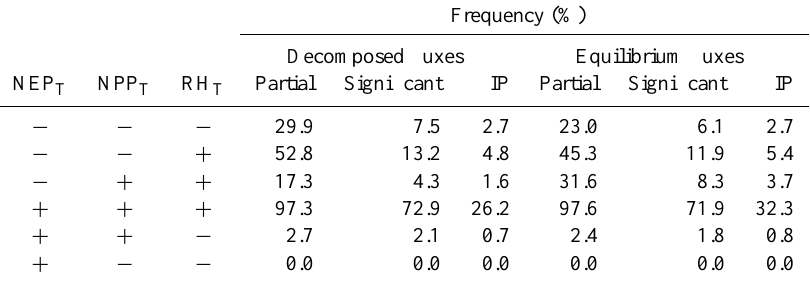
Table 6. Results for the decomposition of NEP trends into NPP and R H trends for NEP D and NEP eq . The partial frequencies are estimated dividing the occurrence of NPP T and RH T combinations by the total occurrence of positive or negative trends (depending on the NEP T column). Significant frequencies are calculated dividing the occurrence of NPP T and RH T combinations by the total of significant trends for the IP region. The fraction of significant trends over the Iberian Region is identified with